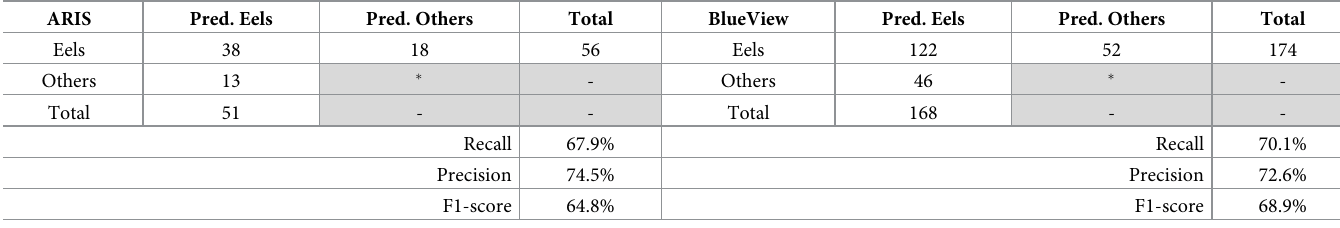
� True negatives were not counted.